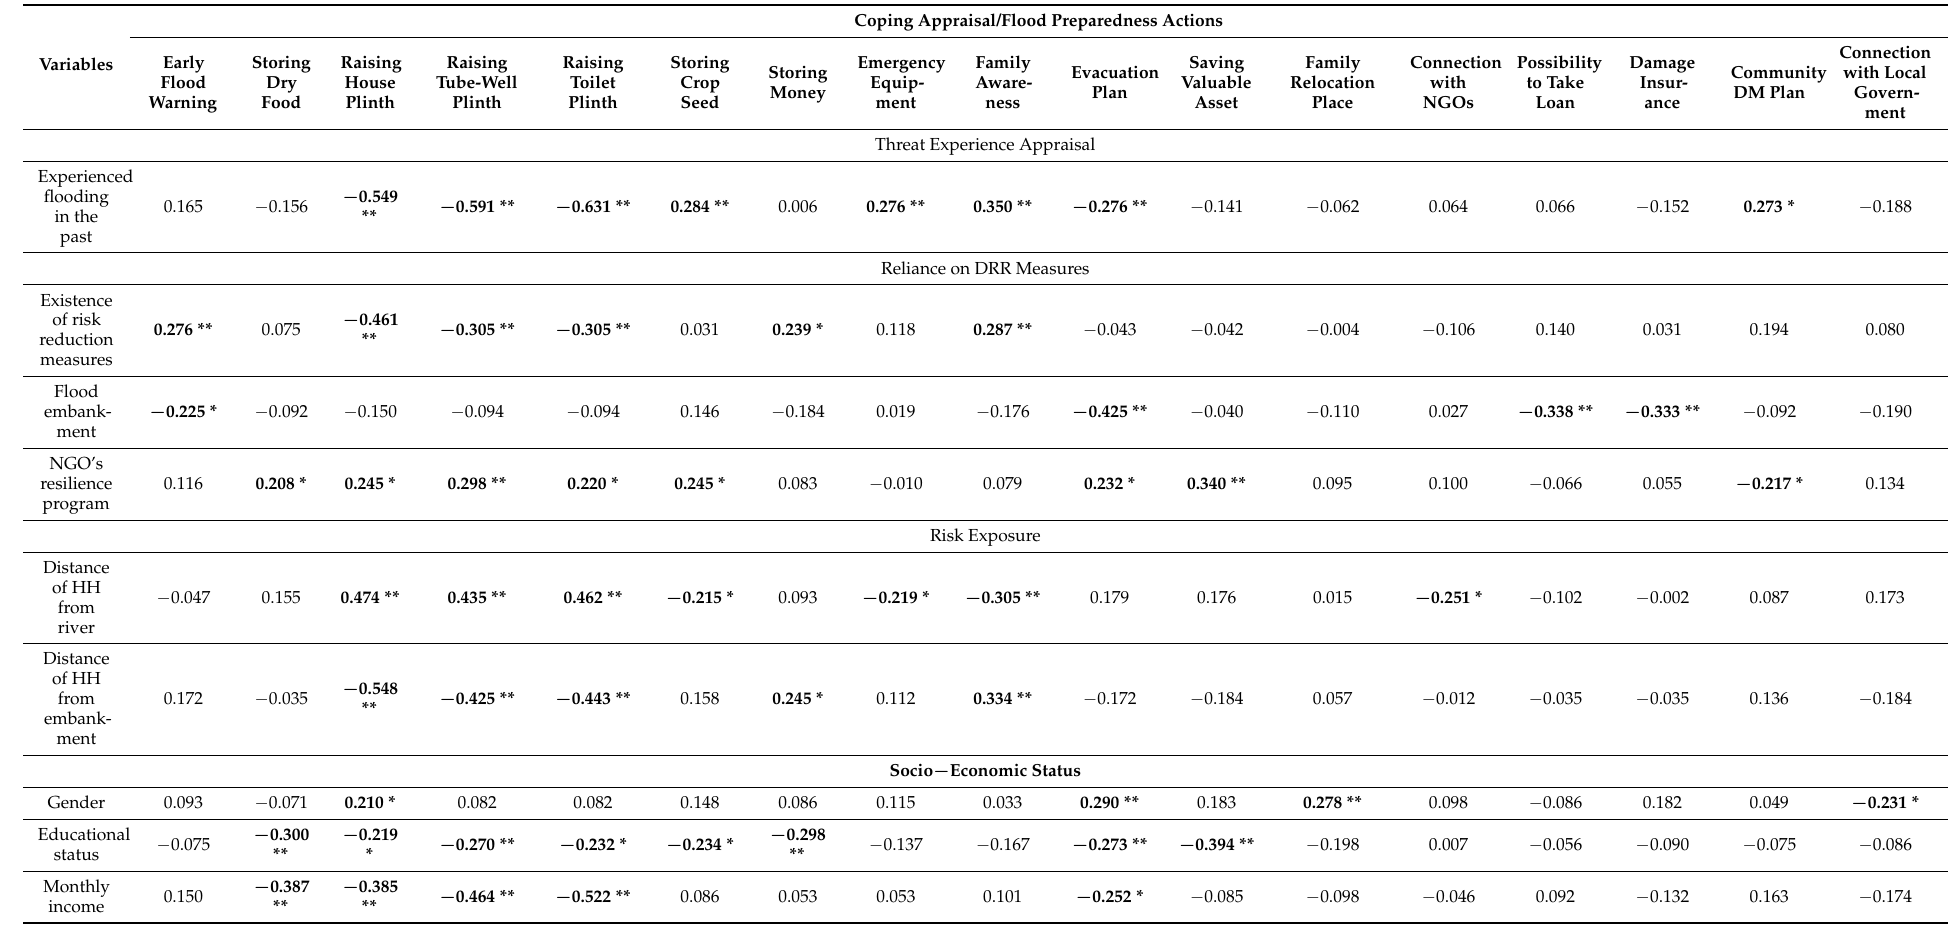
Table A2. Correlations among variables related to flood experience, reliance, risk exposure, socio-economic status, and coping-appraisal